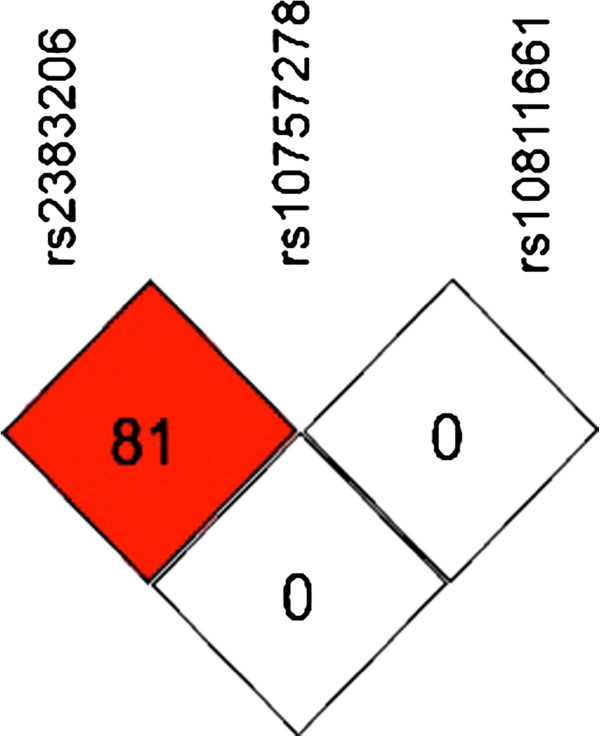
Total mortality in type 2 diabetes patients in relation to the rs10811661 genotypes. Survival curves indicate a lower risk for total mortality in carriers of both risk alleles of the ‘T2D’ variant rs10811661 compared to patients either homozygous or heterozygote for the non-risk allele. The HR was adjusted for multiple baseline covariates (model 2).